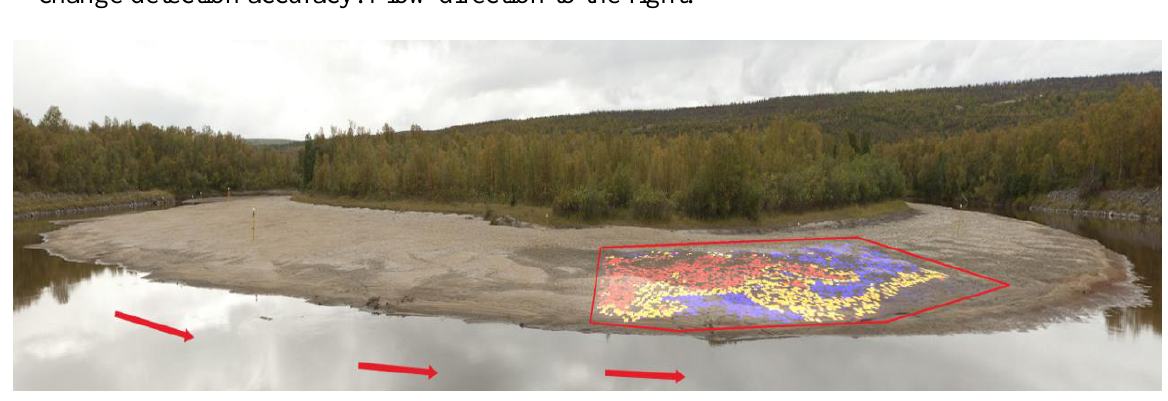
Figure 4. Panoramic image of Point Bar 1. The marked area was selected for assessing change detection accuracy. Flow direction to the right.